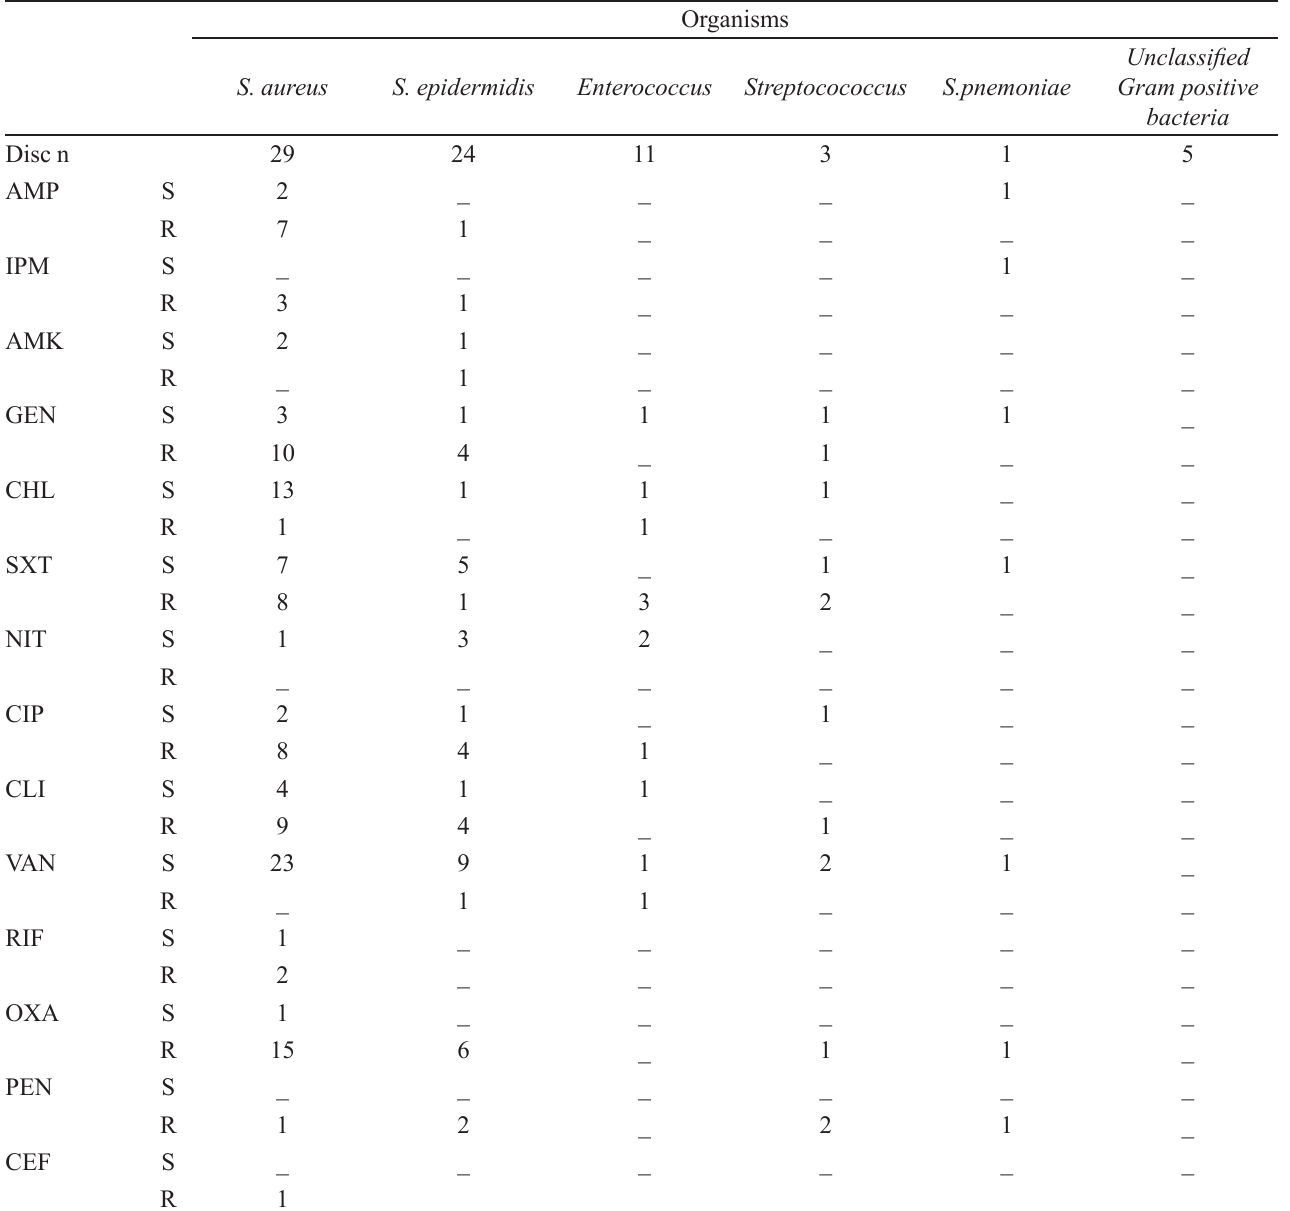
TABLE II - Susceptibility rates of the most common Gram-positive cocci isolated from the